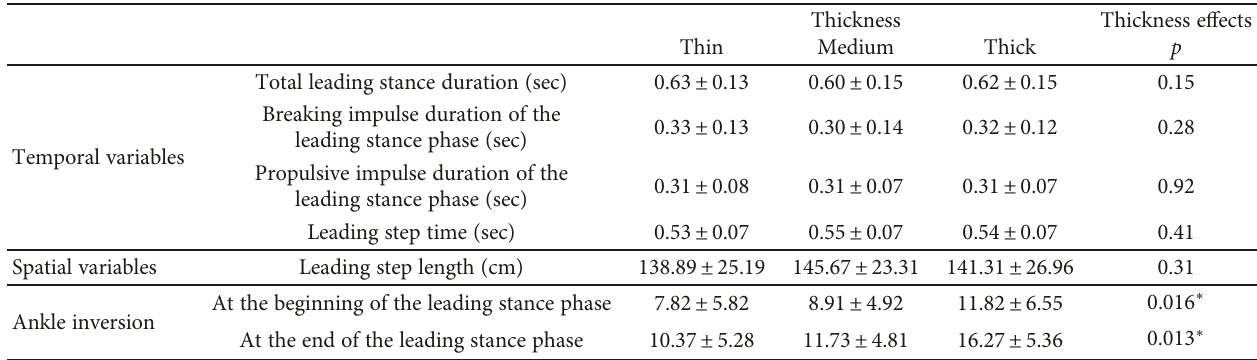
Table 1: Temporal-spatial variables and ankle inversion at each of the critical events during side cutting movement for the three midsole thicknesses (thin, medium, and